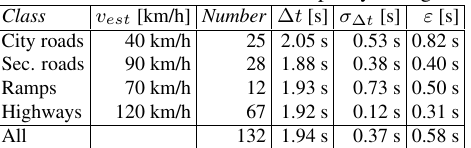
Table 2: Car measurements in RapidEye image Class